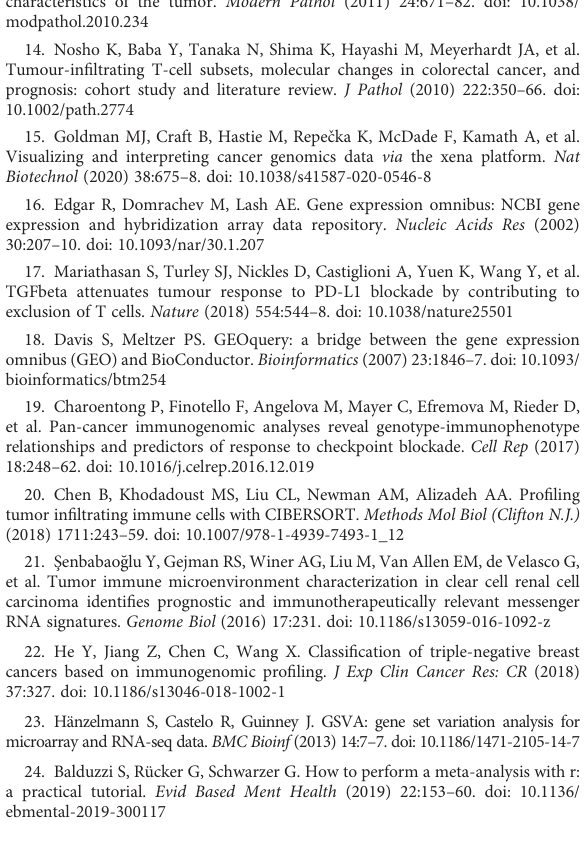
SUPPLEMENTARY FIGURE 2 Prediction of response to immunotherapy using SubMap. ( A, B) . SubMap prediction of response to anti-PD1 and anti-CTLA4 treatment in TCGA cohort (A) and GSE39582 cohort (B) . SUPPLEMENTARY FIGURE 3 Transcriptomic, genomic and immune characterizations of IRScore. (A). Circos plots of GSEA-based Cancer Hallmarks pathways (top) and KEGG pathways (bottom) differences between high and low IRScore groups